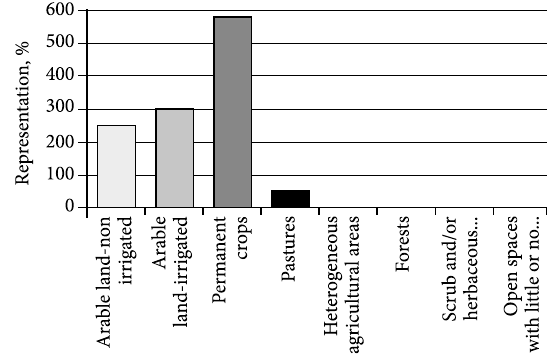
2015)Fig. 5. Land use representativeness of the COST action field sites vs. the EU28 agricultural area. 100% means that the proportion of field sites is the same as the proportion of the agricultural area for the EU28. A representation value >100% indicates over-representation, and a value <100% indicates under-representation (Feb. 2015)